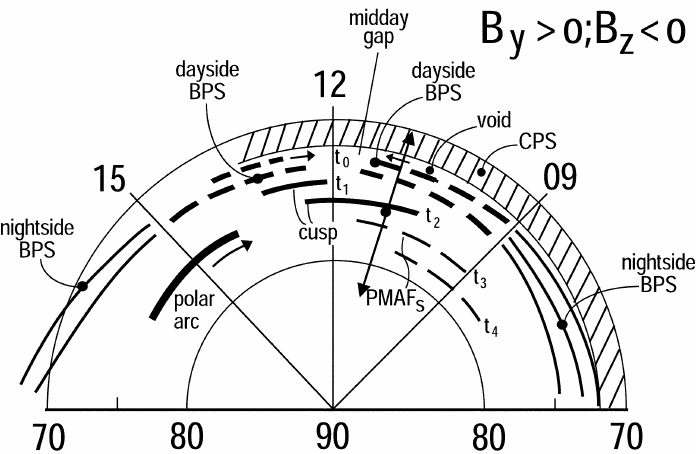
Figure 12 Fig. 12. Schematic overview of the dayside auroral configuration inMLAT/MLT coordinates for the “intermediate” clock angle regime (IMF B y > 0 conditions). Auroral forms are named after their respective particle precipitation sources. Auroral motions are indicated by arrows. The spatio-temporal evolution of the auroral response (PMAF activity) to magnetopause reconnection events (FTEs) is indicated by labels t 0 – t 4 . The field of view of the MSP in Ny ˚Alesund (at ∼ 08:00 UT) is marked by double-arrowed meridional